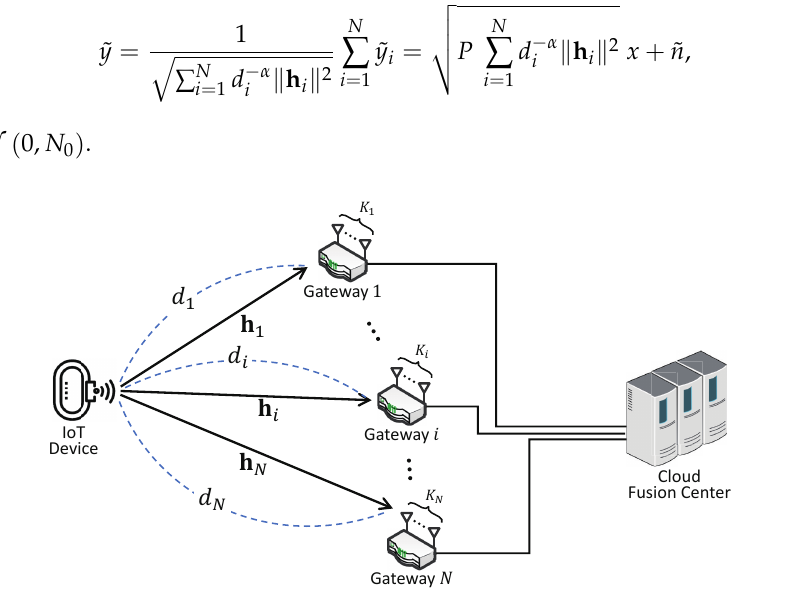
Figure 1. Uplink cooperative technique in a low-power wide-area network (LPWAN) with multiple antenna gateways